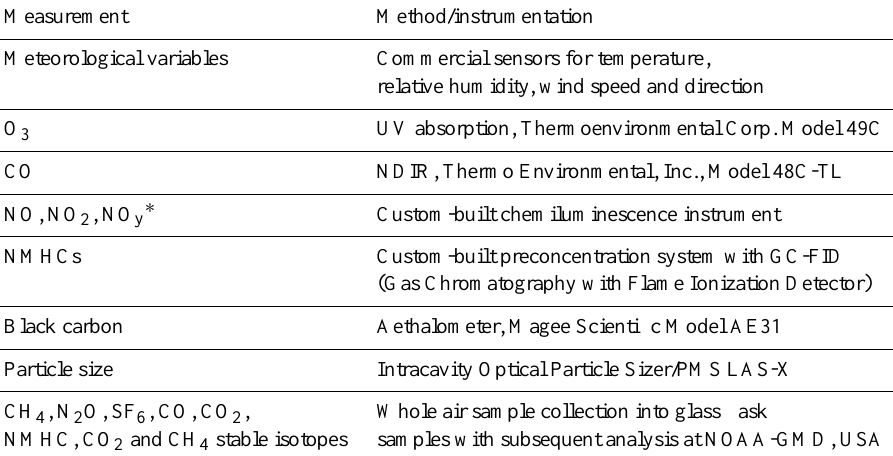
Table 5. Chemical and physical atmospheric observations at the Pico Mountain Atmospheric Research Observatory during BORTAS phases A and B.